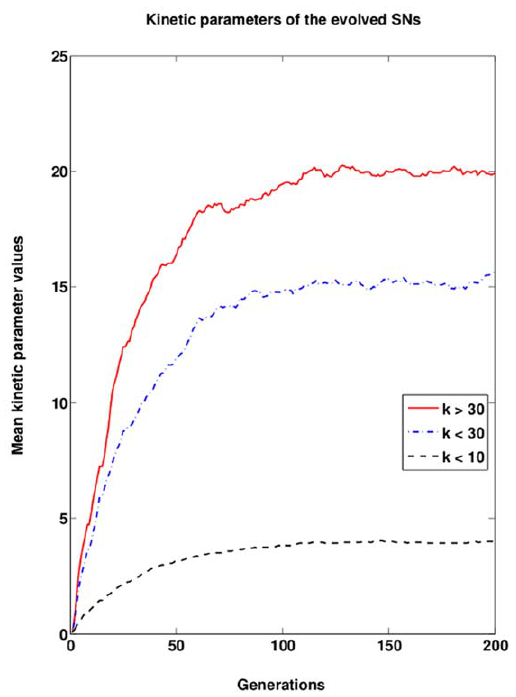
Figure 5. Mean kinetic parameter values of networks during evolution. The numeric values for all kinetic parameters in the SN are averaged omitting the formal difference of first-order and second-order reactions (see Methods).